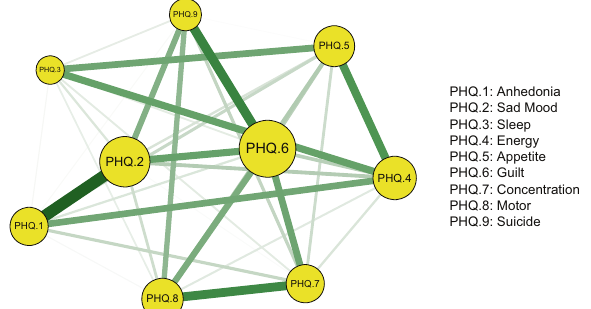
Fig. 1 Estimated network model for dichotomized depressive symptoms in the total sample. The network model was estimated using the Ising model.